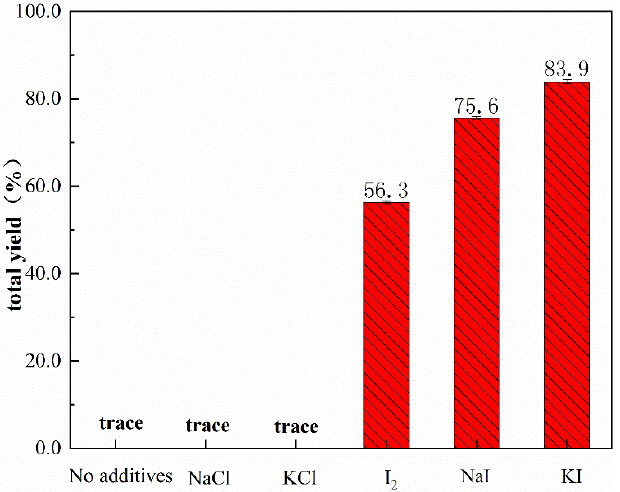
Figure 11. Effect of different cocatalysts on the dicarbonylation of acetylene. Reaction conditions: catalyst (10 mg), acetylene (11 mmol), MeOH (20 mL), KI (112 mg), P CO = 1.8 MPa, Ptotal = 4.0 MPa, T = 343.2 K, t = 5 h.